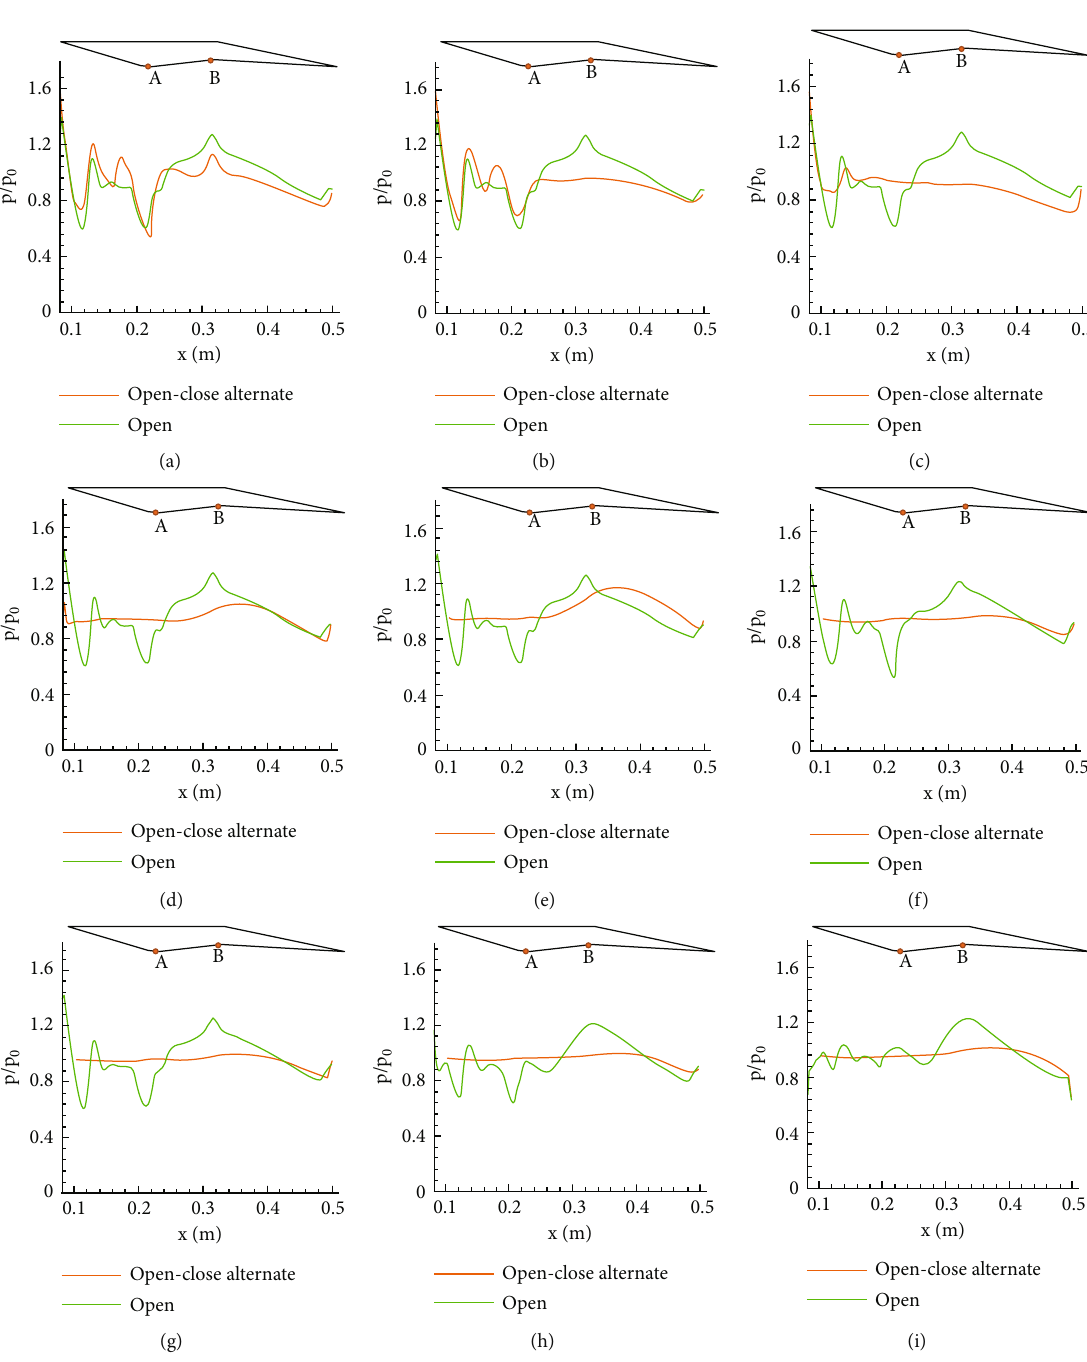
Figure 9: Pressure changes in the monitoring curves along the tail